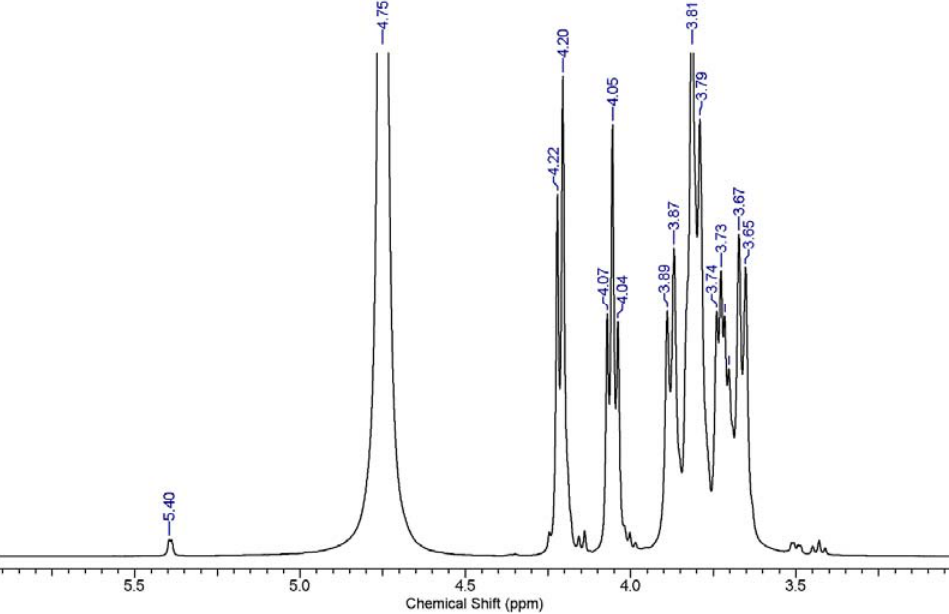
Figure 9. 1 HNMR of raw inulin.